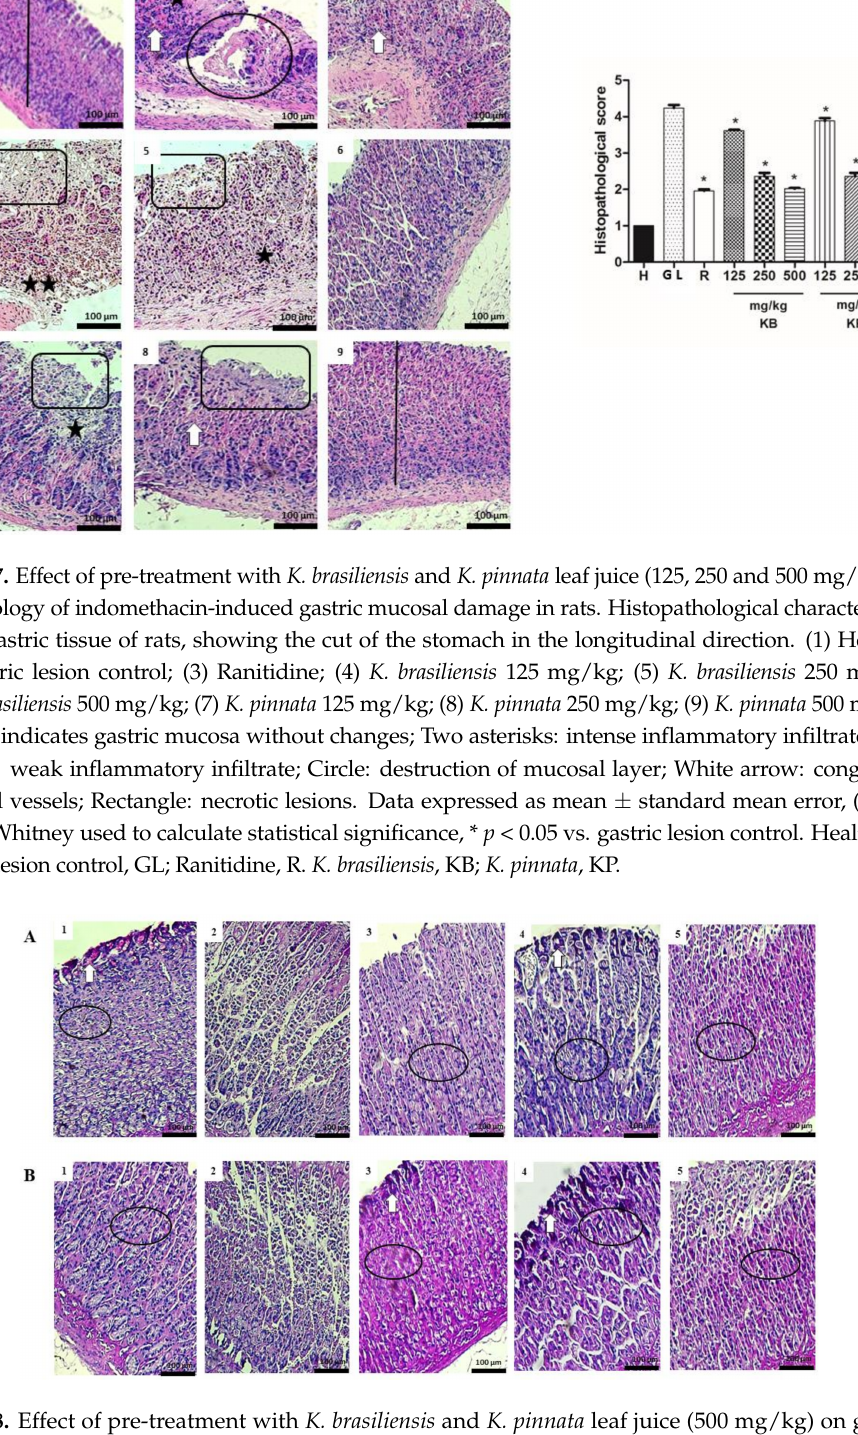
Figure 8. Effect of pre-treatment with K. brasiliensis and K. pinnata leaf juice (500 mg/kg) on gastric tissue glycoprotein-PAS staining in ethanol-induced and indomethacin-induced gastric lesions in rats. ( A ) Ethanol-induced: (1) Healthy; (2) Gastric lesion control; (3) Ranitidine 50 mg/kg; (4) K. brasiliensis 500 mg/kg; (5) K. pinnata 500 mg/kg. ( B ) Indomethacin-induced: (1) Healthy; (2) Gastric lesion control; (3) Ranitidine 50 mg/kg; (4) K. brasiliensis 500 mg/kg; (5) K. pinnata 500 mg/kg. White arrow: the strong PAS staining; Circle: preservation of mucus in goblet